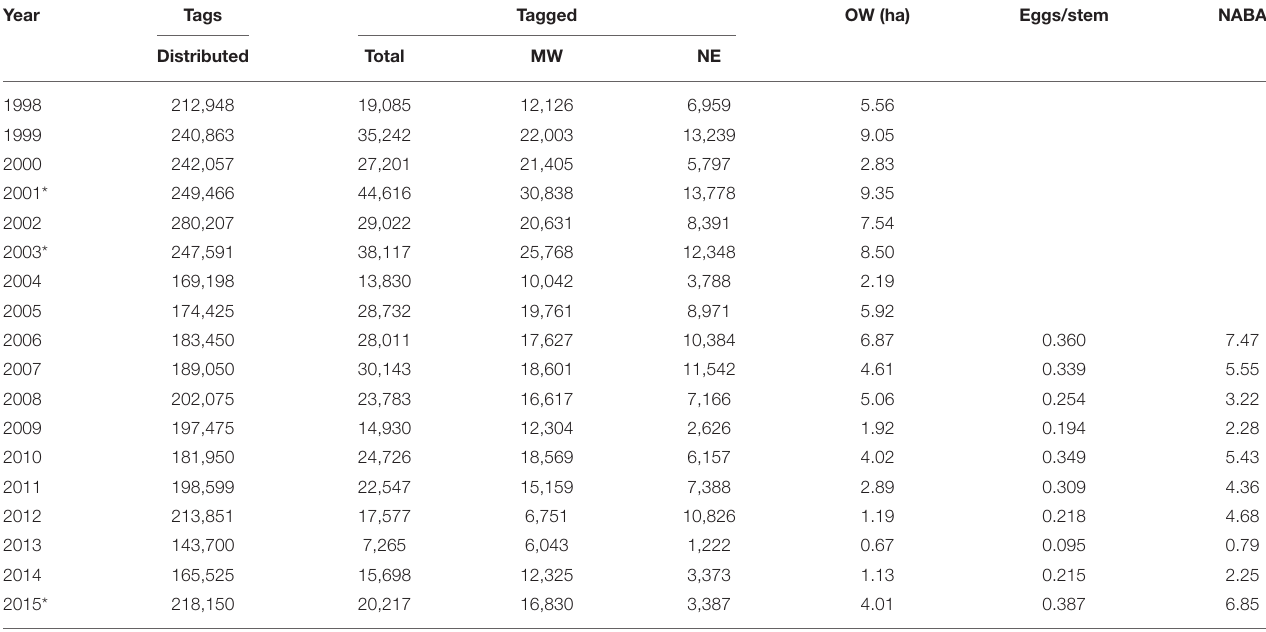
TABLE 1 | The number of wild-caught tagged monarchs for all geographic sectors north from 40 to 50 ◦ latitude and east from 100 to 65 ◦ longitude and the numbers tagged for the Midwest and Northeast portions of that region (see Figure 1 ). Year Tags Tagged OW (ha) Eggs/stem NABA Distributed Total MW NE